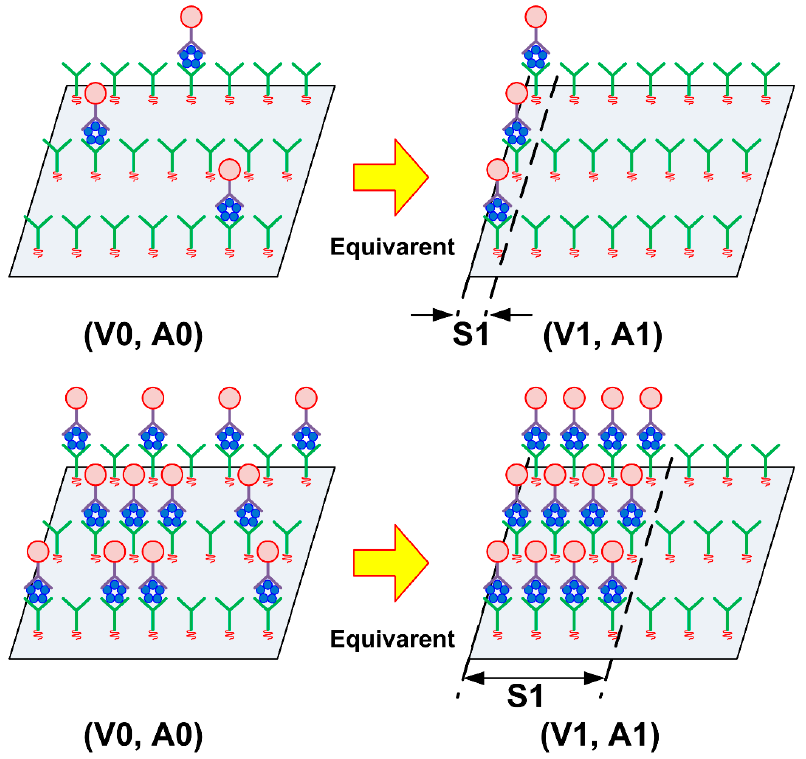
Figure 11. Comparison of number of antigen–antibody reactions on the sensing area.